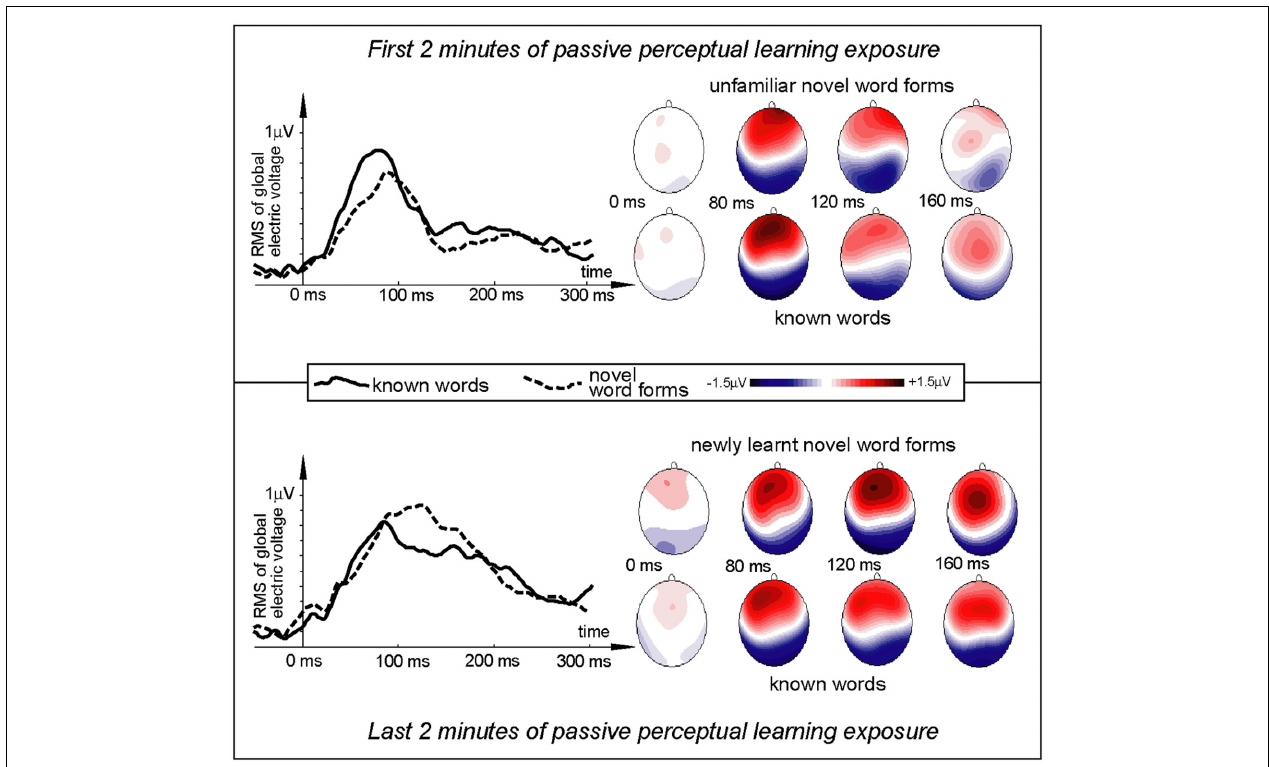
FIGURE 2 | Electric brain response (global activation computed as RMS across all EEG electrodes; grand-average data) for word and pseudo-word stimuli early and late in the learning session. Responses are time-locked to the stimulus uniqueness points (second syllable onsets) when each stimulus could first be identified. Note the larger word response early in the session and the pseudo-word response increase by the end of the